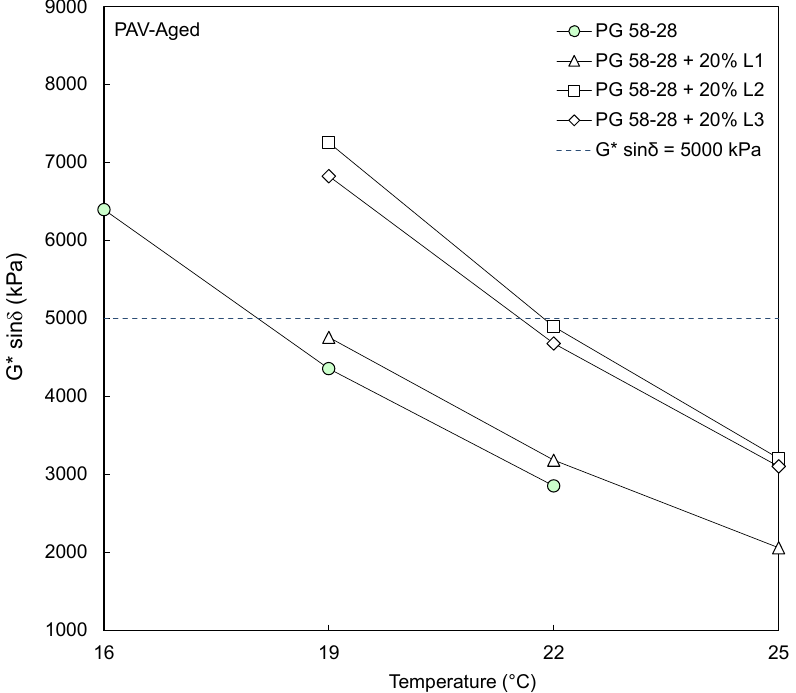
Figure 7. Fatigue parameters of PAV-Aged PG 58-28 Binder Blends.